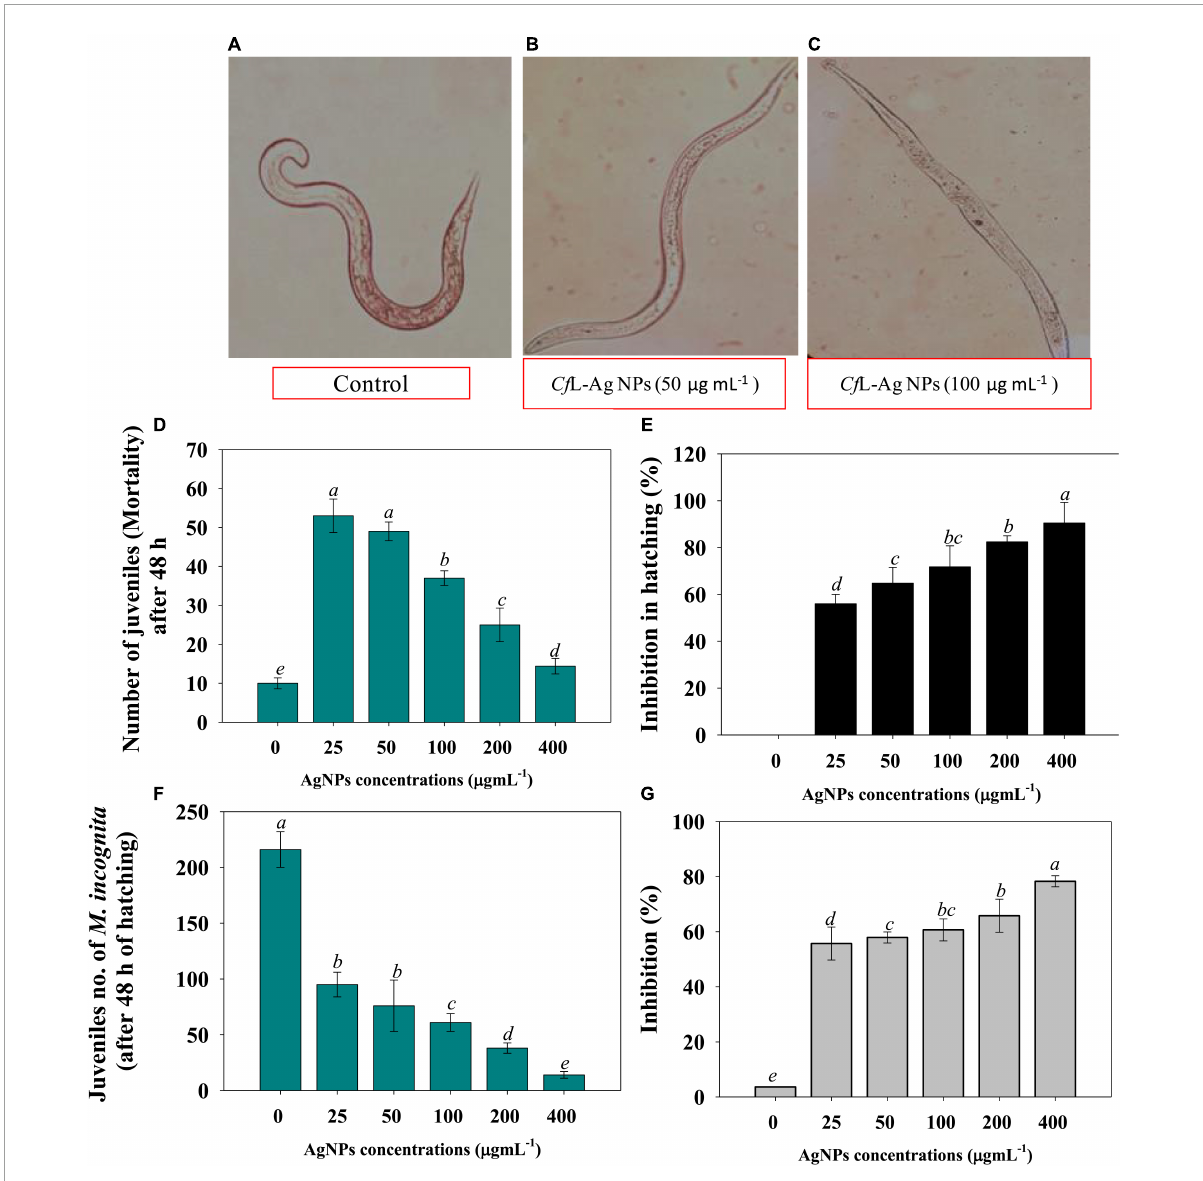
FIGURE4 (A–C) Represent the microscopic examination of root-knot nematode Meloidogyne incognita treated with 0 (control), 50 and 100 µ g Ag@ Cf L-NPs ml − 1 , respectively. (D,E) Shows the effect of Ag@ Cf L-NP son number of juveniles of M. incognita after 48 h of hatching and percent inhibition in hatching, respectively. (F,G) Depicts the impact of green-synthesized Ag@ Cf L-NP son number of juveniles (mortality) after 48 h and inhibition percentage, respectively. In this figure, bar diagrams represents the mean values of three replicates ( n = 3). Corresponding error bars represents standard deviation (S.D) of three replicates (S.D, n =